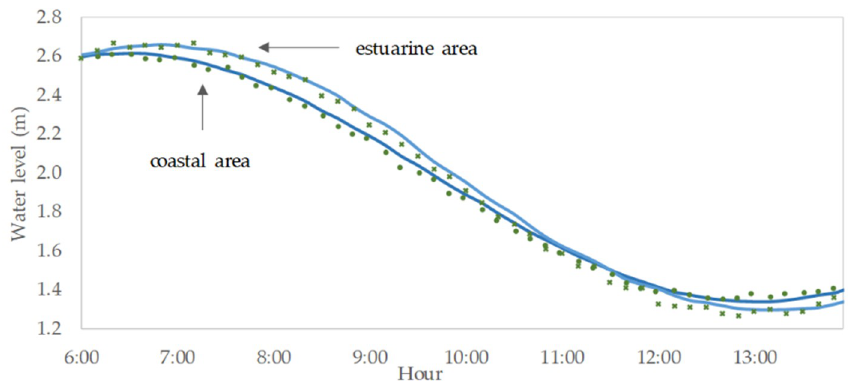
Figure 4. Tidal wave lag between CTG (coastal area) and LTG (in the Tagus estuary) stations. Green dots and crosses represent observed data whereas blue lines represent the modelling results.